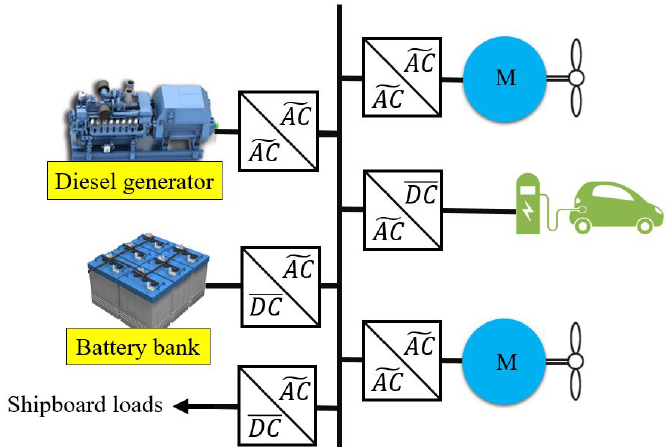
Figure 1. Single-line electric block diagram of the ship.